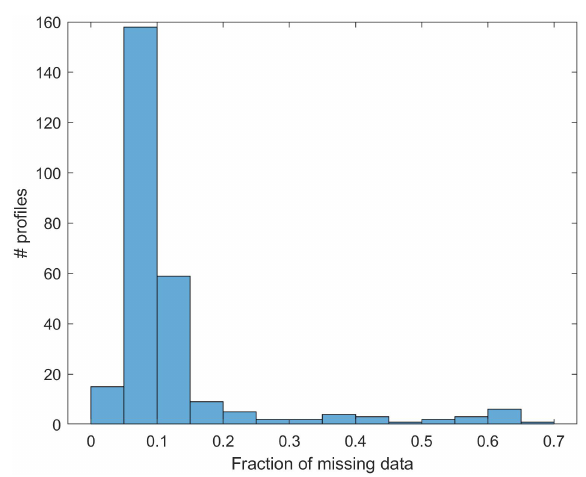
Figure 5. Frequency distribution of the missing data fraction in the Many_nan data set.